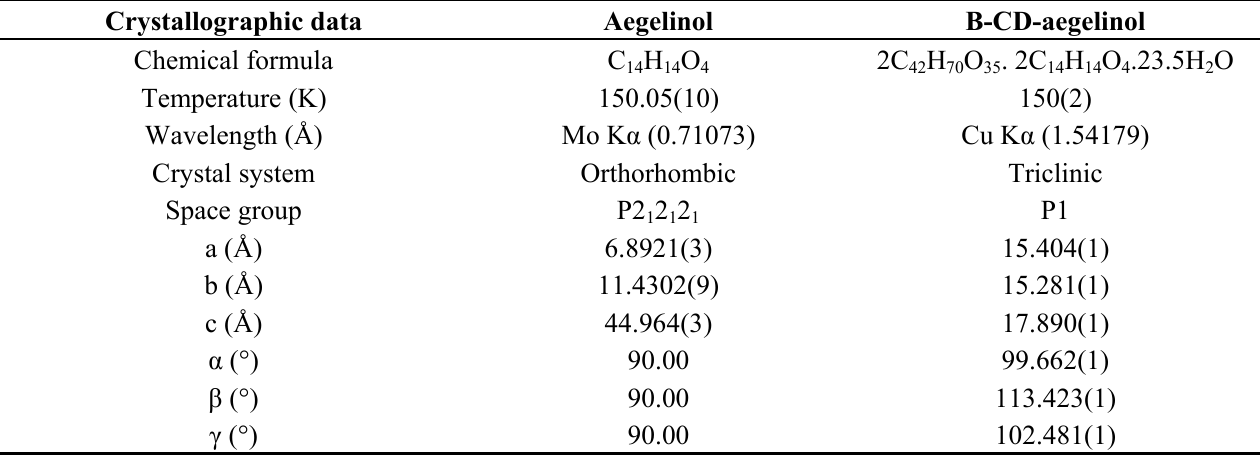
Table 1. Main statistics on data quality and refinement for the crystal structures